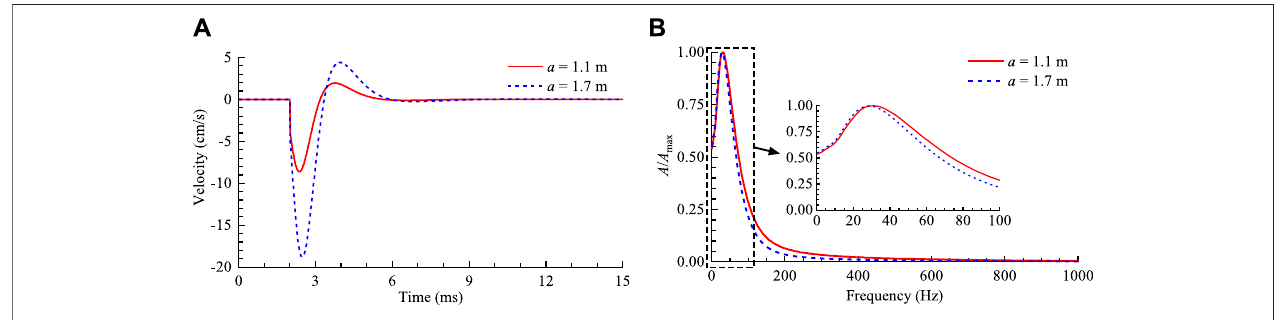
FIGURE 16 | PPV of the stress release-induced vibration under different blasthole